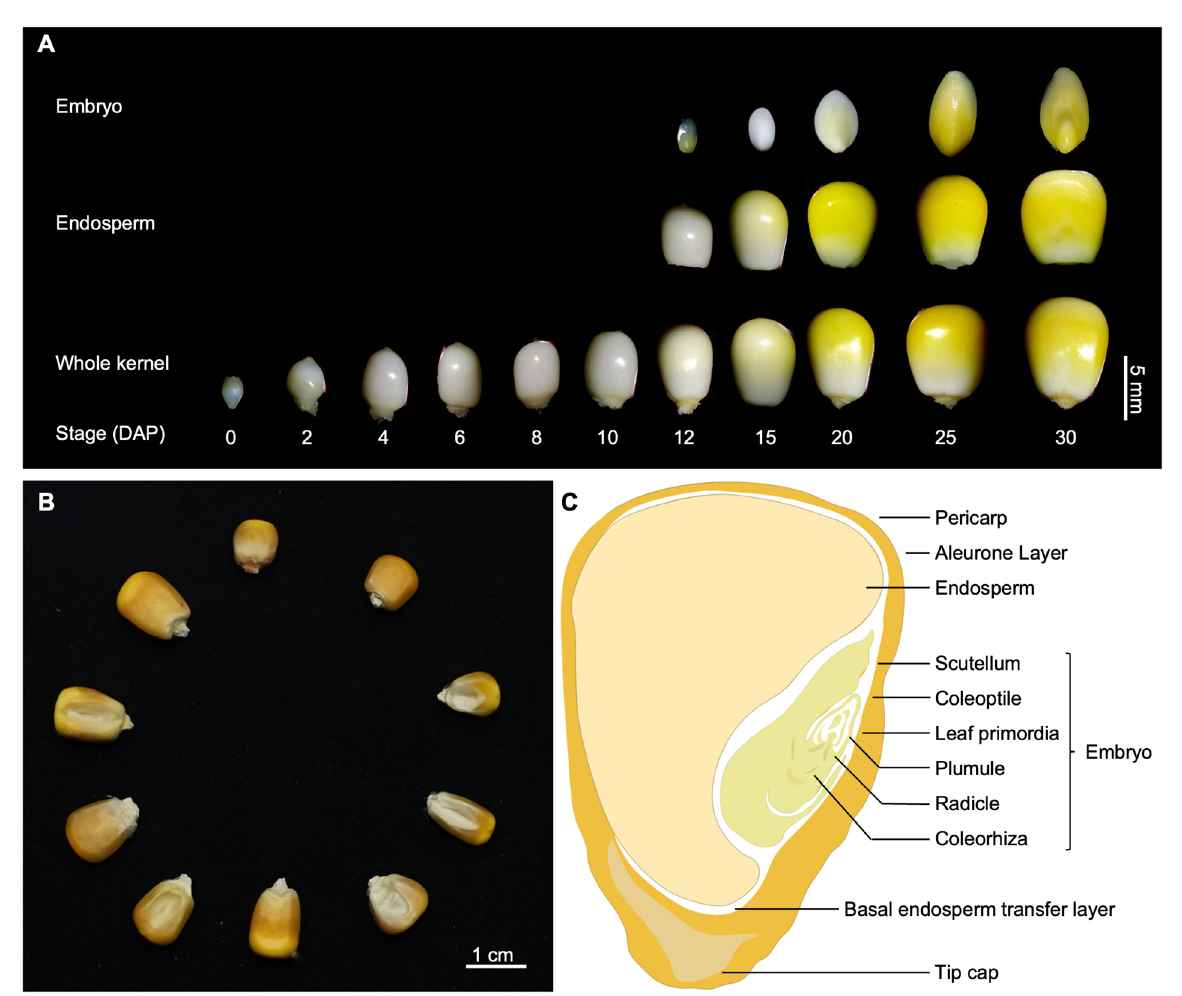
Figure 1. Illustration of maize kernel developmental period and structure. ( A ) Overview of kernel developmental stages in maize inbred line B73 (DAP, days after pollination). ( B ) Seed size diversity in different maize lines. ( C ) Diagram of maize kernel structure.